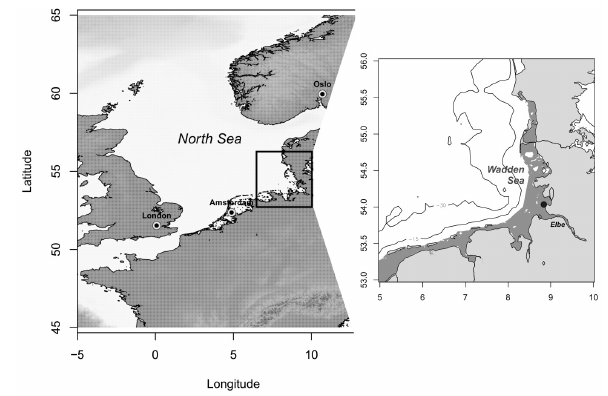
Figure 1. Sampling